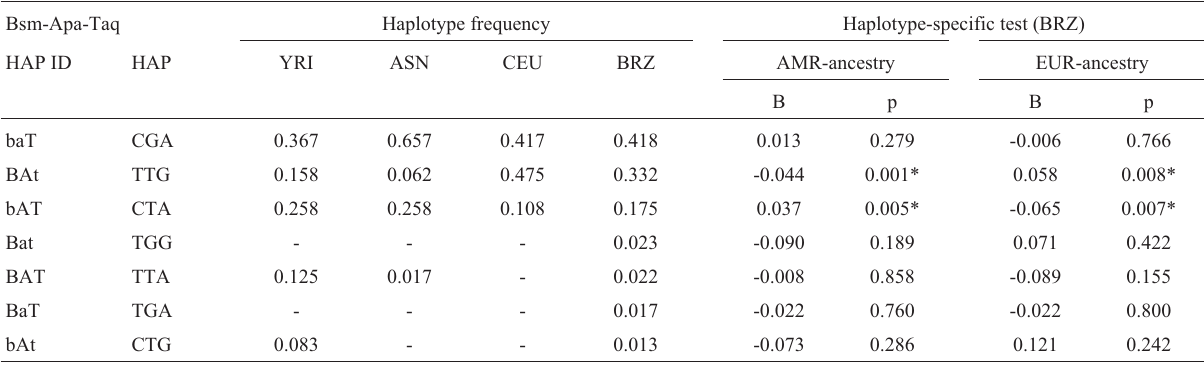
Table 5 - Distribution of the Bsm-Apa-Taq haplotype frequencies among different populations and the association between Brazilian populations and European (EUR) and Amerindian (AMR)